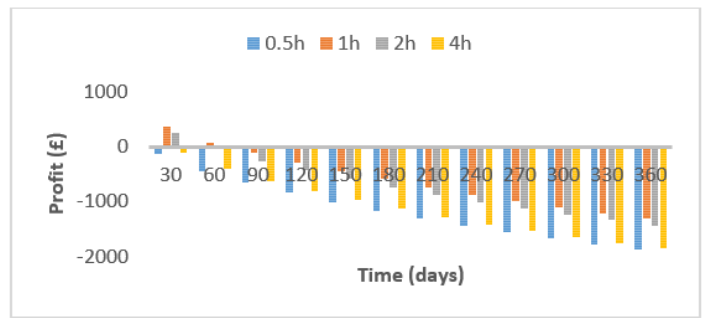
Figure 10. Profitability of the four de-rated batteries over 1 year when λ cl = £6/kW/year.